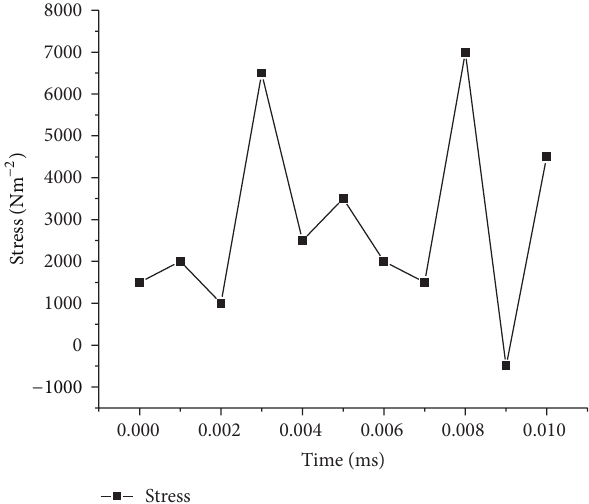
Figure 9: Surface stress on cantilever beams at different time inter-